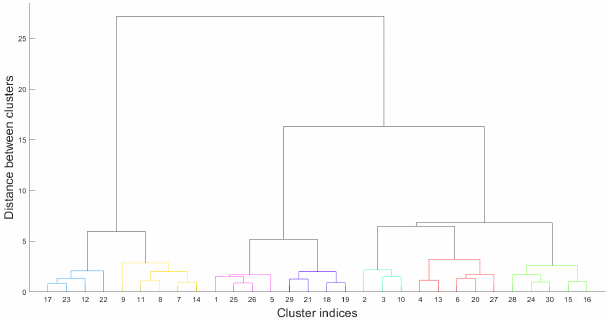
Figure 9. Grouped links depicting the number of